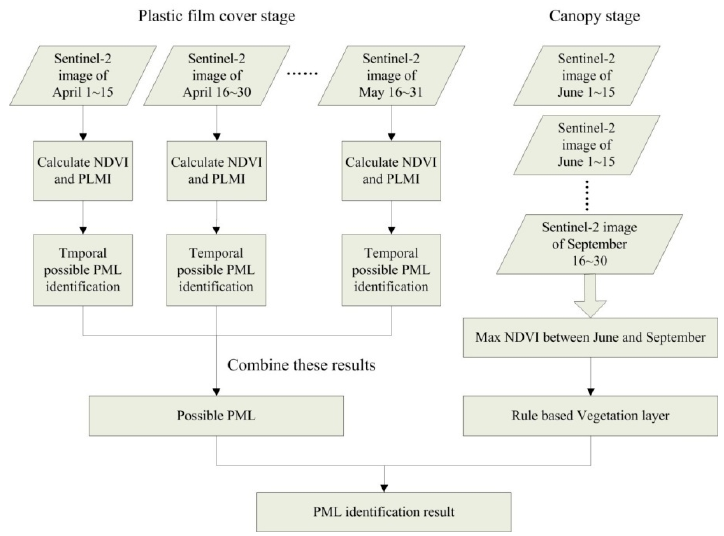
Figure 3. Flowchart of MTPML of PML identification.